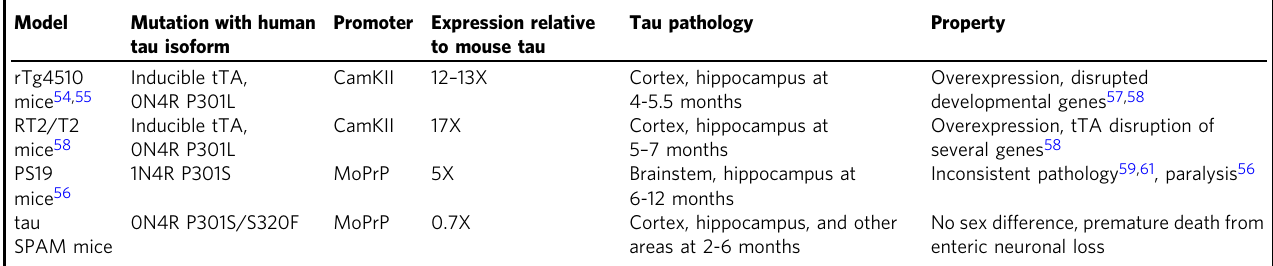
Table 1 Comparison of some commonly used transgenic mouse models of tauopathies to the new tau SPAM mice.